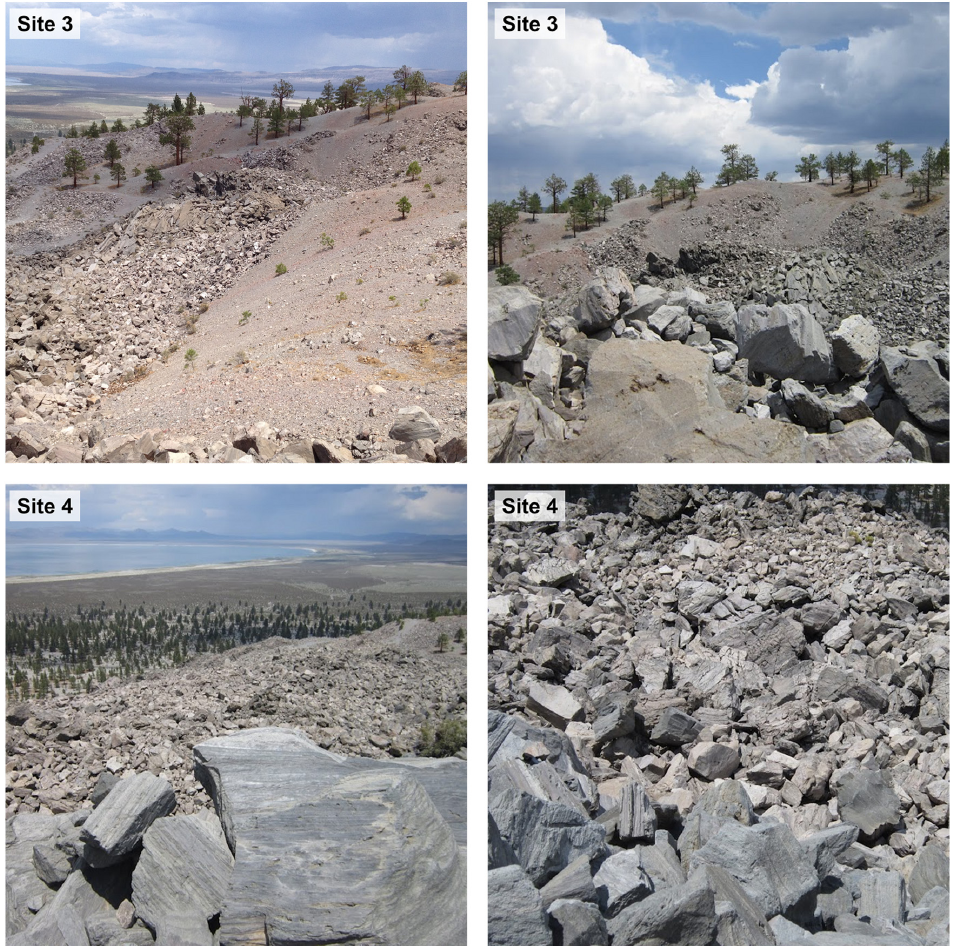
Figure 8. Field photographs of Site 3 ( upper row ) and Site 4 ( lower row ) with context images shown in the left hand column and close-up images in the right hand column. Site 3 has a strongly bimodal particle size consisting of mantling similar to Site 2 as well as a non-mantled primary lava flow surface (blocks). Site 4 is a completely non-mantled location on the coulee. The block size distribution measured along a transect for this site is shown in Figure 9.